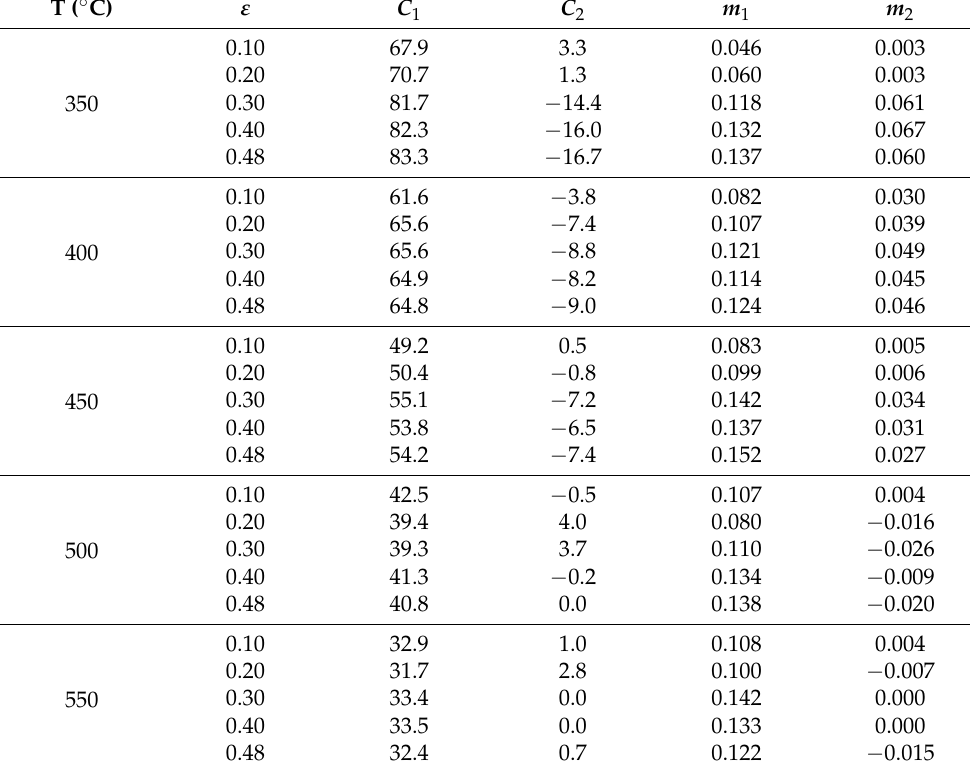
Table 5. Flow constants of the fitted